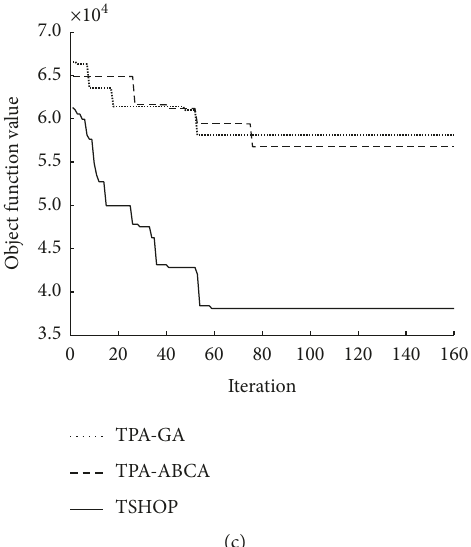
Figure 11: Comparison for solution performance with iteration number of algorithms under different size problems. (a) Instance with 16 item tasks. (b) Instance size with 24 item tasks. (c) Instance with 34 item